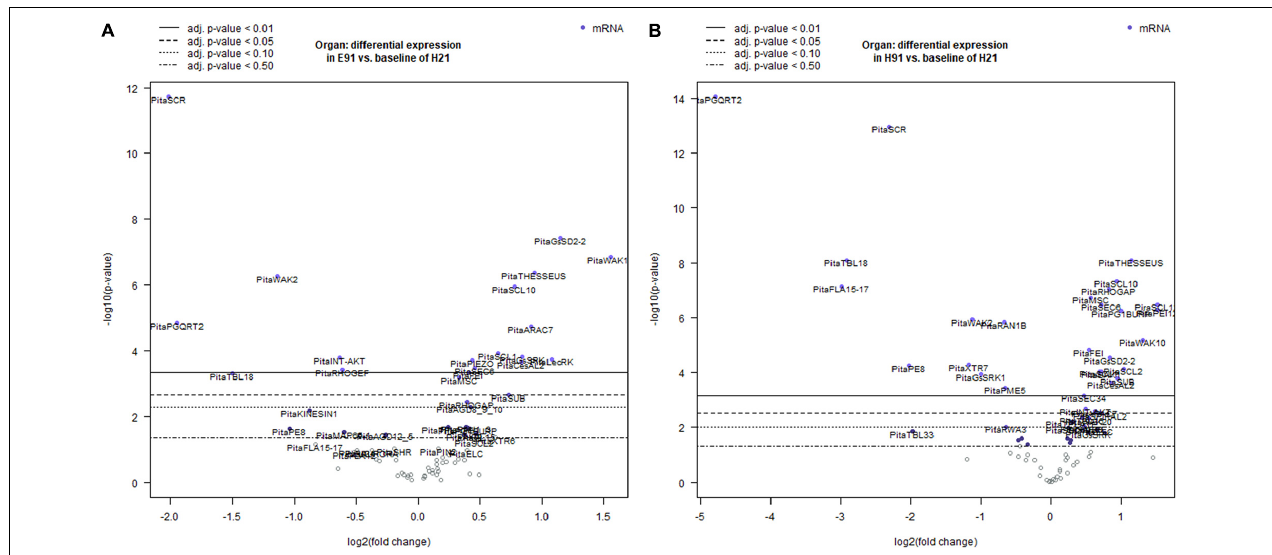
FIGURE 2 | Volcano plots of a linear regression of the differential gene expression in epicotyl (A) and hypocotyl (B) cuttings from 91-day-old seedlings (E91 and H91, respectively) during adventitious root formation using the gene expression in hypocotyl cuttings from 21-day-old seedlings (H21) as the baseline. Point colors and horizontal lines indicate various false discovery rate (FDR)